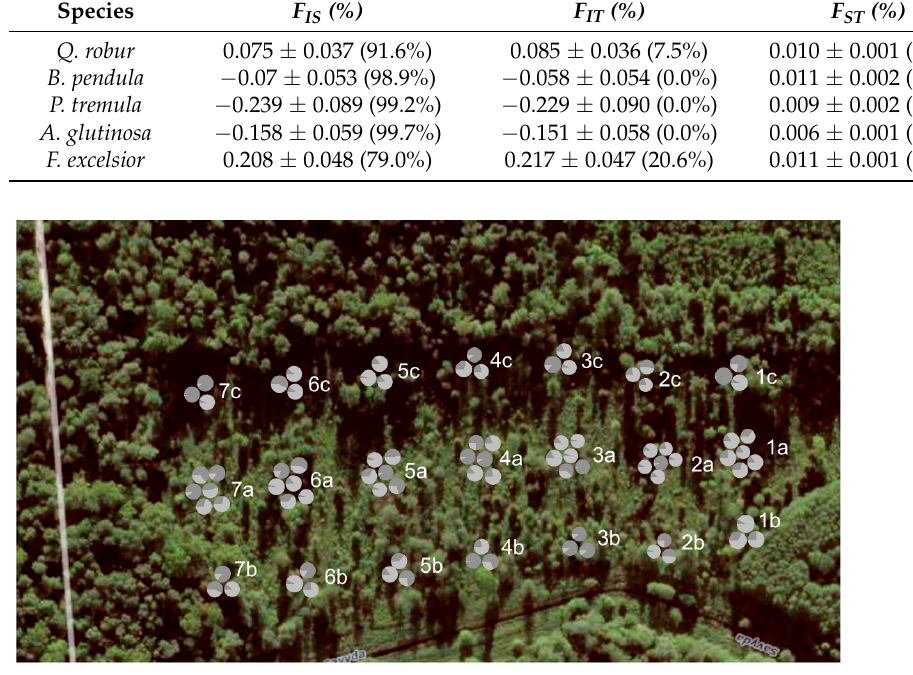
Figure 4. Spatial distribution map of sampled common oak ( Quercus robur L.) juveniles regenerating on a sanitary clearcut site (see Figure 1 for the principal sampling scheme). Pie charts show the assignment of individual juvenile MLGs to the two most likely genetic clusters, as revealed by STRUCTURE (indicated in different shades of grey).